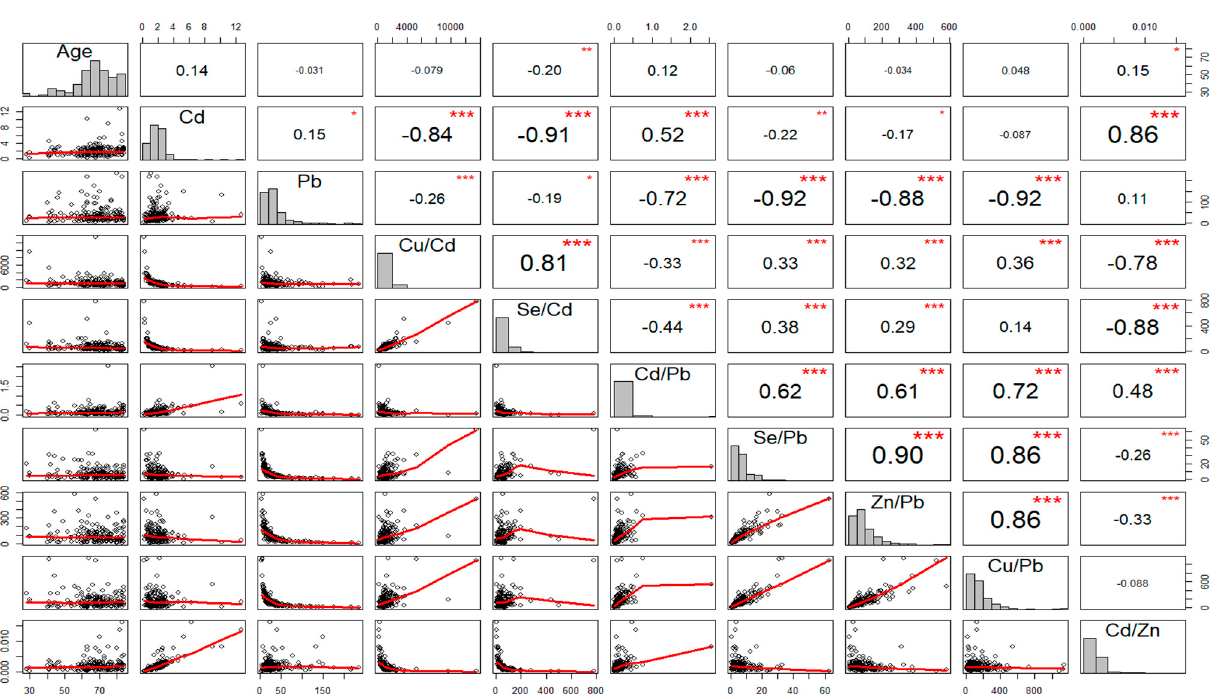
Figure 1. Scatter-matrix, histogram, and Spearman rank correlation matrix of essential trace elements, toxic elements and molar-ratio levels of the aforementioned components in patients with acute ischemic stroke. p -values < 0.05 showed statistical validity; * p < 0.05, ** p < 0.01, *** p < 0.001.